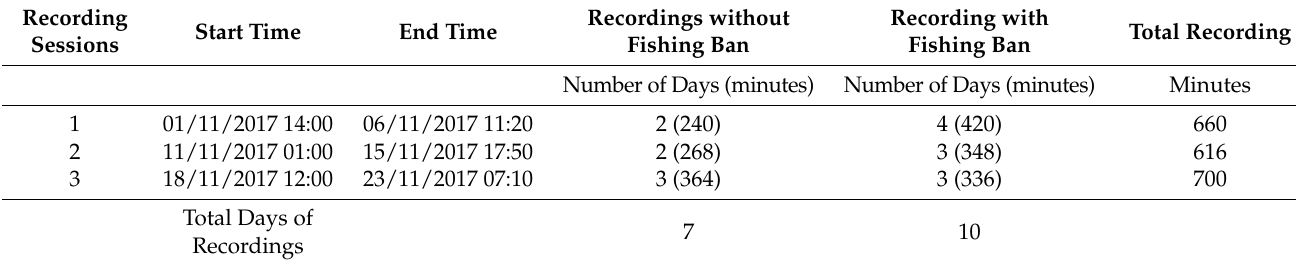
Table 1. Data collection following a duty cycle of 2 min of recording and 8 min of